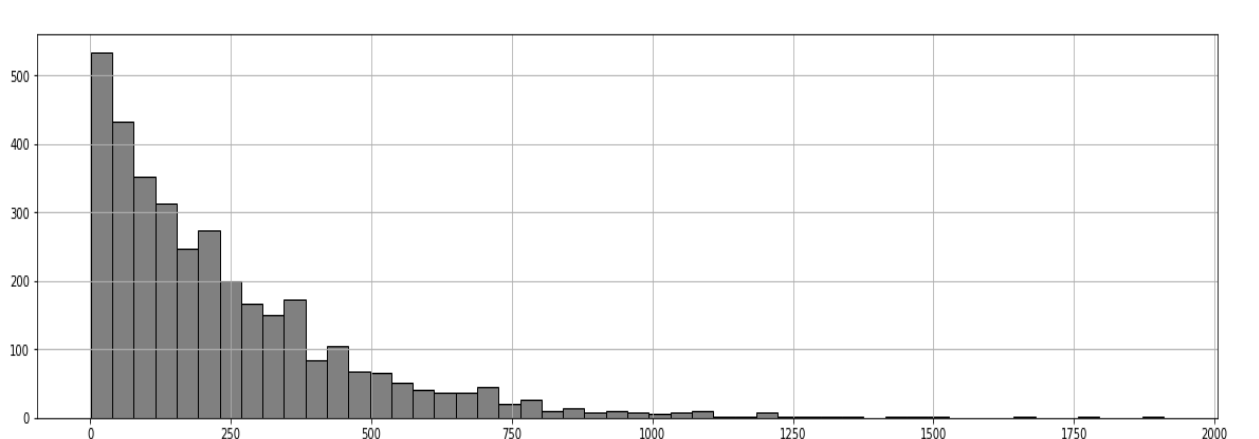
Figure 9. Machine age analysis. ( a ) Error counts by the machine’s age; ( b ) failures by the machine’s age.